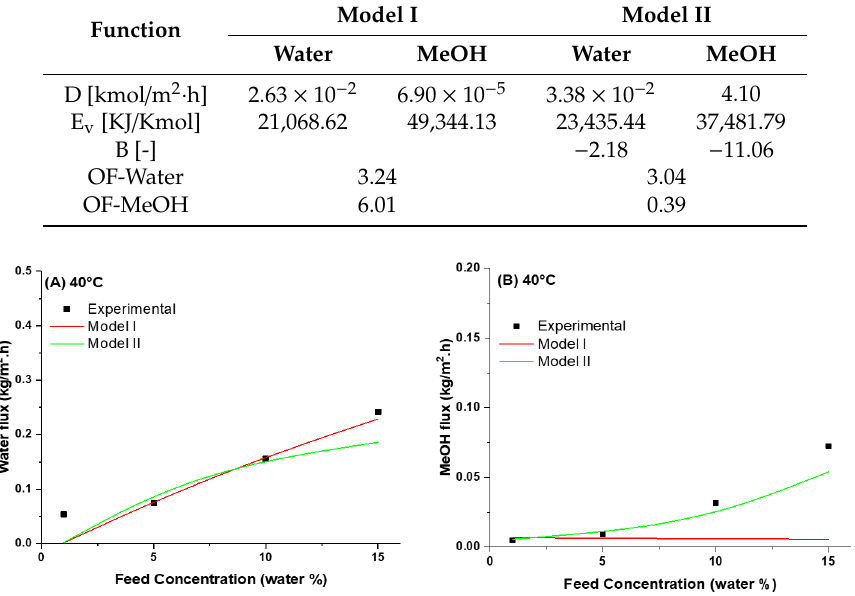
Table 3. Estimated parameters for a methanol − water mixture using the PVA10 mixed matrix membrane. Model Function